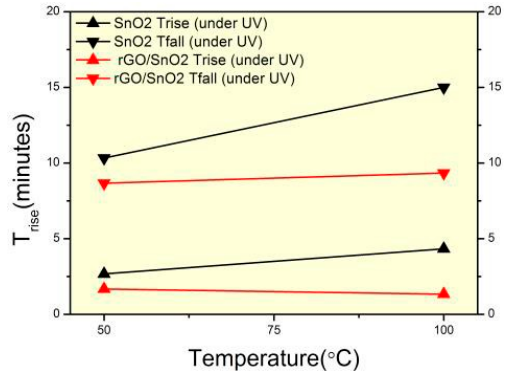
Figure 3. Response time and recovery time of the SnO 2